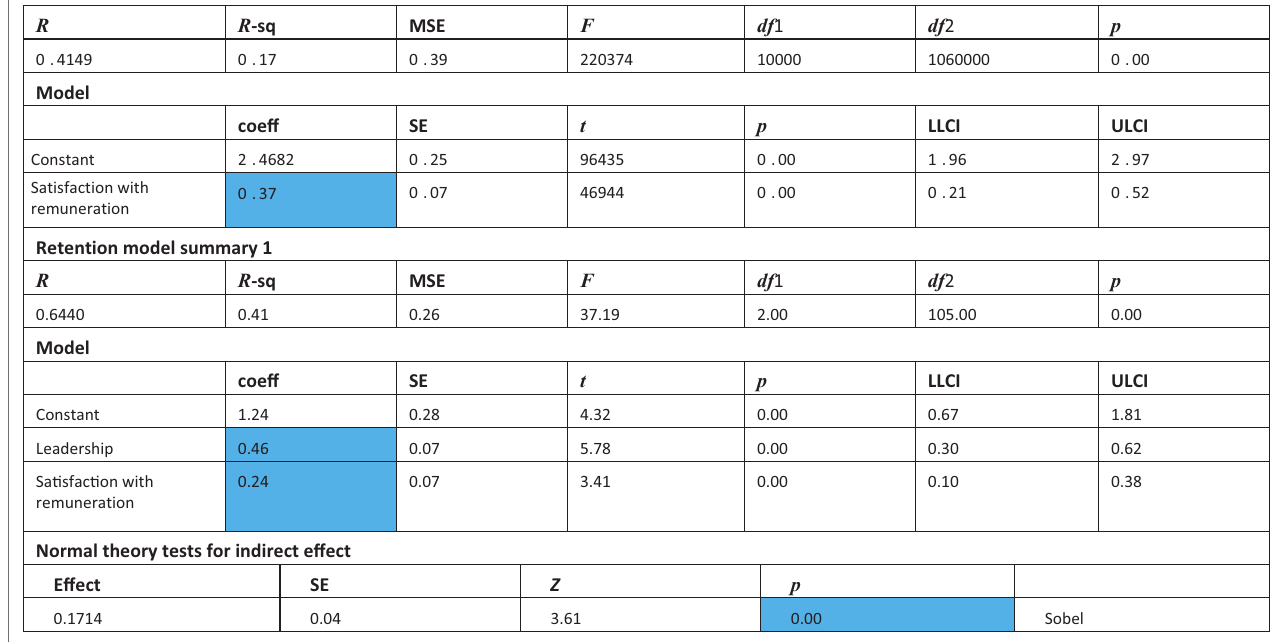
FIGURE 3: Leadership mediation